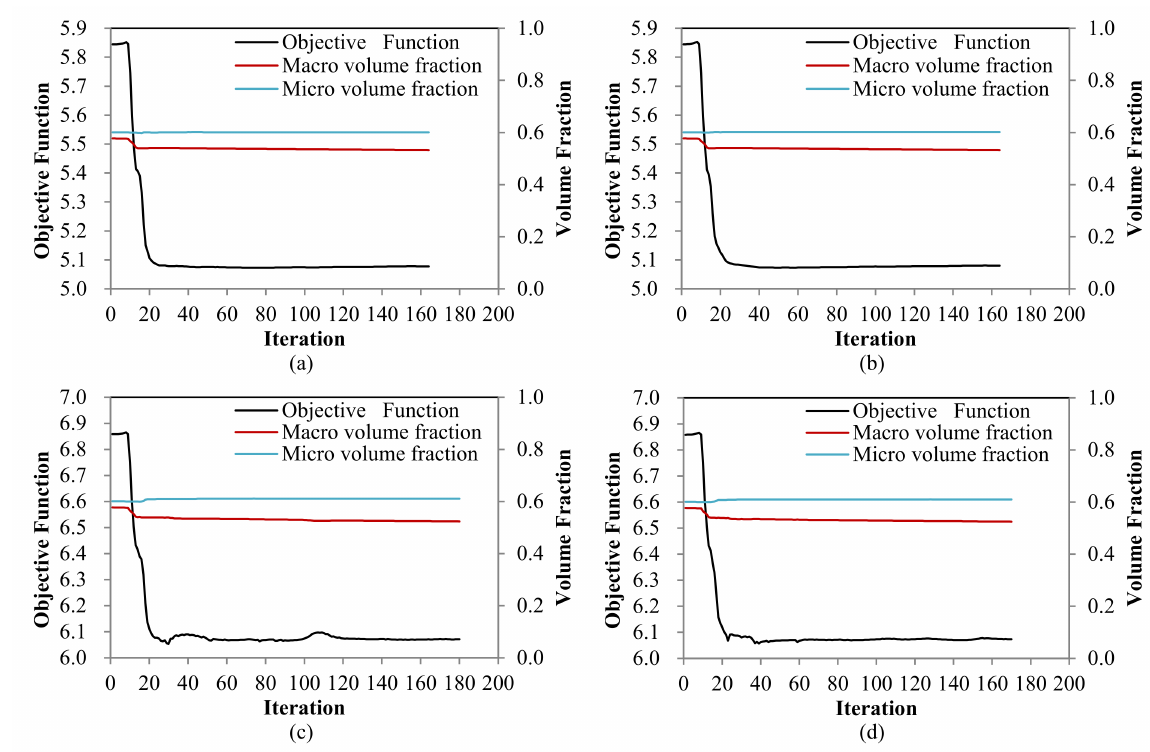
Figure 8. Iteration histories. ( a – d ) are the iteration histories of design cases shown in Figure 7a–d,